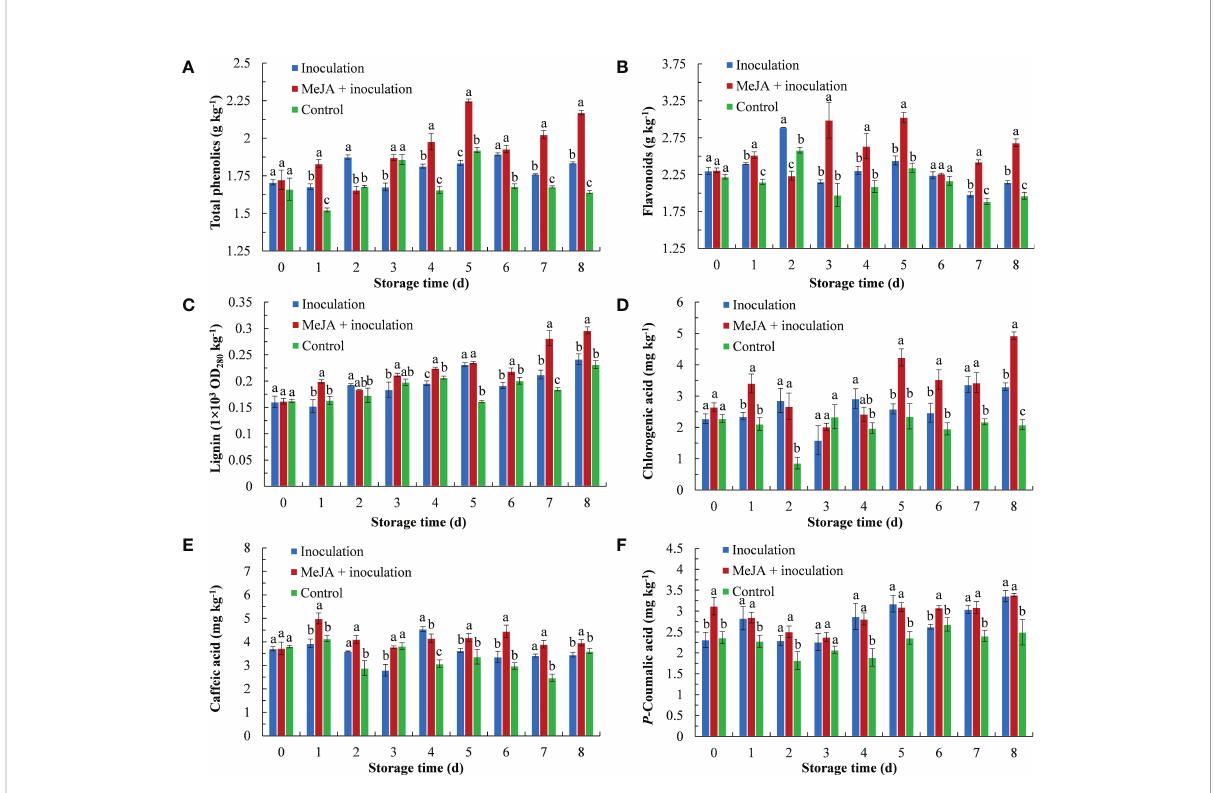
FIGURE 3 MeJA affected the content of (A) total phenolics, (B) fl avonoids, (C) lignin, (D) chlorogenic acid, (E) caffeic acid and (F) p -coumaric acid in kiwifruit during storage time. Bars shows standard deviation (SD, n=3). Letters indicate signi fi cant differences at P < 0.05 level among the